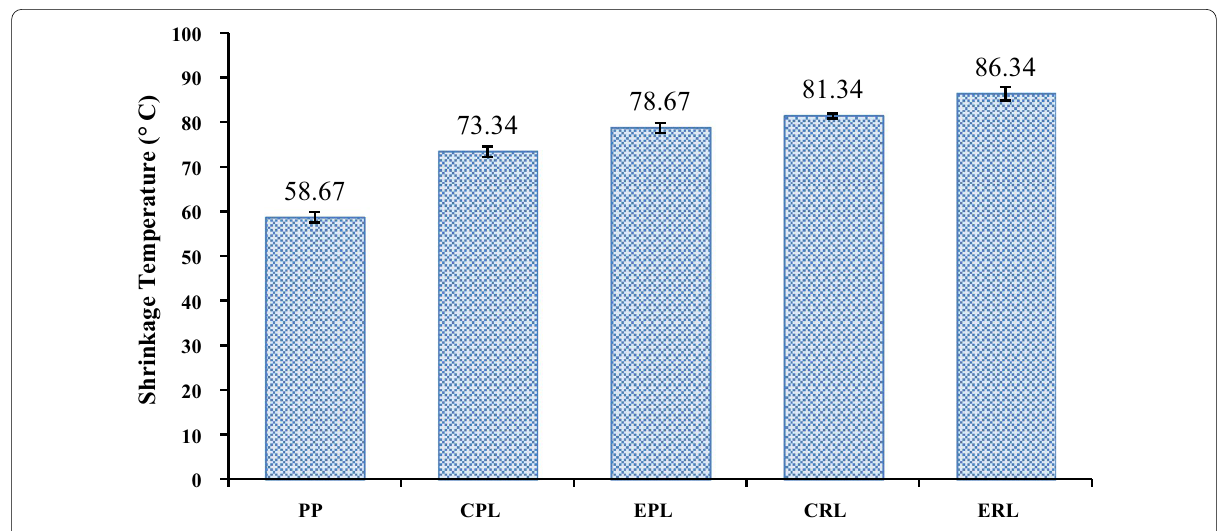
Fig. 7 Shrinkage temperature (Ts) of leather tanned by extracted and conventional tannin